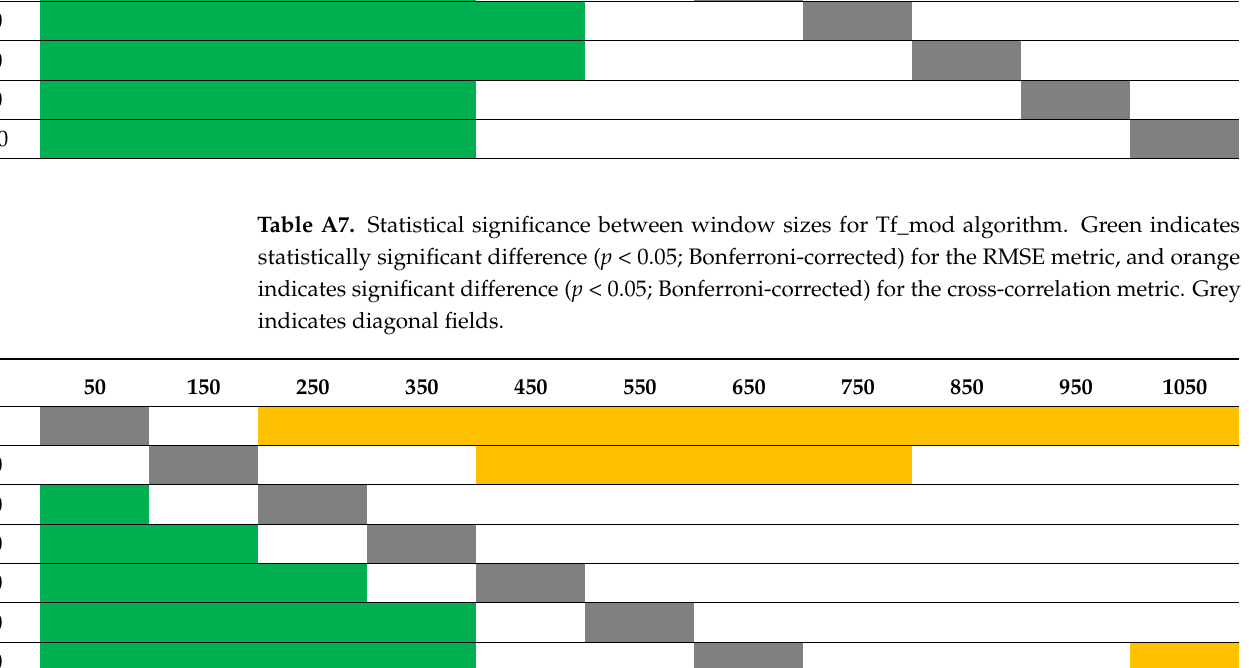
Table A7. Statistical significance between window sizes for Tf_mod algorithm. Green indicates